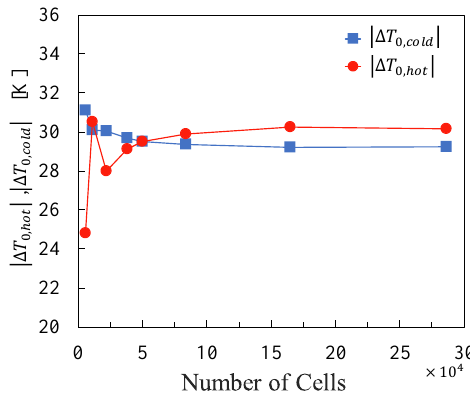
Figure 2. Grid convergence test.